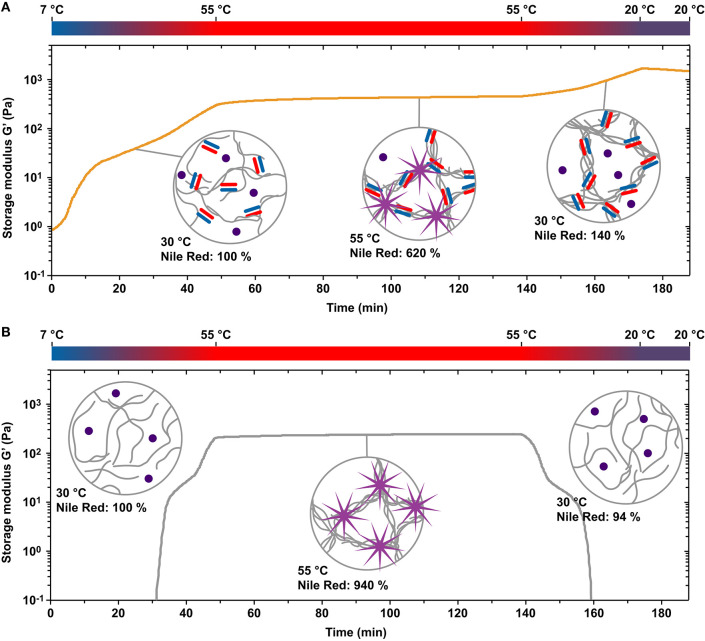
Temperature-induced hydrophobic bundle formation and gelation of PIC-A4B4 and PIC-0 hydrogels. (A) Evolution of the storage modulus G′ as a function of time when subjecting PIC-A4B4 to temperature protocol 2 (7°C → 55°C → 20°C). (B) Evolution of the storage modulus G′ as a function of time when subjecting PIC-0 to temperature protocol 2. The measurements were performed with a strain amplitude of 1% and a frequency of 1.6 s−1. Hydrophobic bundle formation was visualized in a temperature-controlled microplate reader using the fluorophore Nile Red, which is known to increase in intensity in hydrophobic environments. The intensity (measured at λex = 540 nm and λem = 655 nm) was normalized to the state of the sample at a temperature of 30°C during the initial heating step.